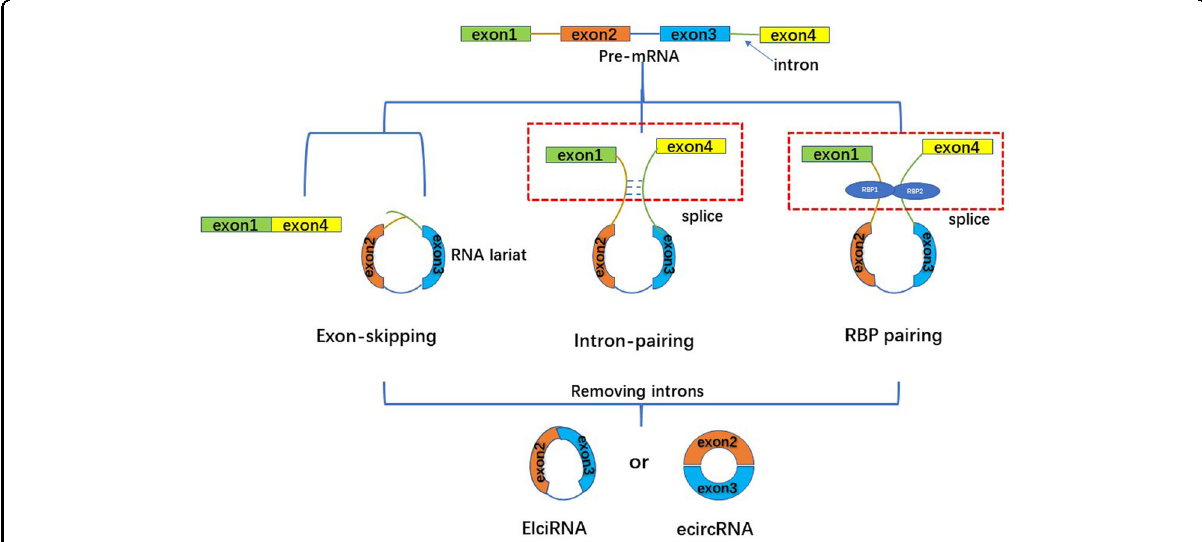
Fig. 2 The formation process of ElciRNA and ecircRNA, including exon-skipping, intron-pairing, and RBP pairing. 1. Exon-skipping: the upstream exon and the downstream exon are covalently bonded to form an RNA lariat containing several exons and introns.The RNA lariat is spliced again, and the intron is removed to form ecircRNA or EicirRNA. 2.Intron-pairing: the two introns fl anking circRNA have complementary structures. The splice sites are brought close by pairing and binding, and the introns are removed to form ecircRNA or EicirRNA. 3. RBP pairing: RBP binds upstream and downstream introns to form a bridge between the introns, and then remove the introns to produce ecircRNA or EicirRNA.